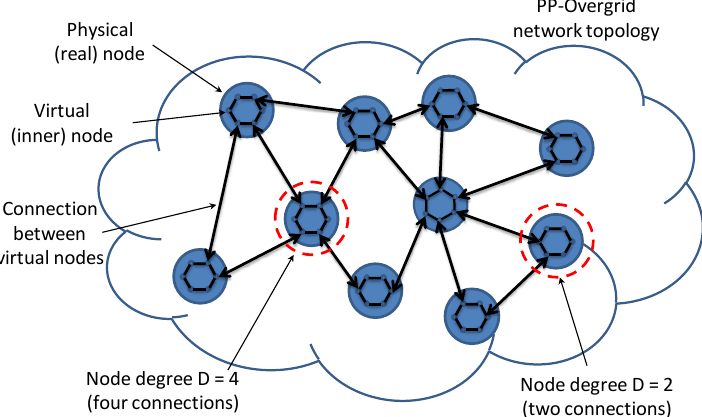
Figure 4. PP-Overgrid logical topology showing the internal ring within the physical